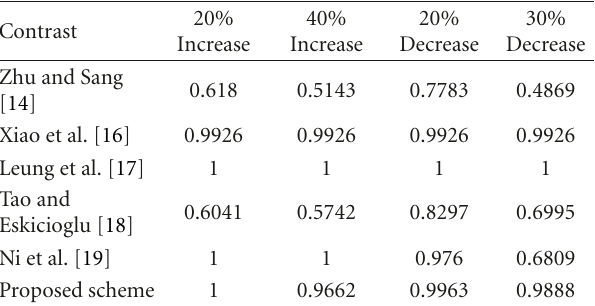
Table 9: Experiment results comparison under contrast attacks (NC values).